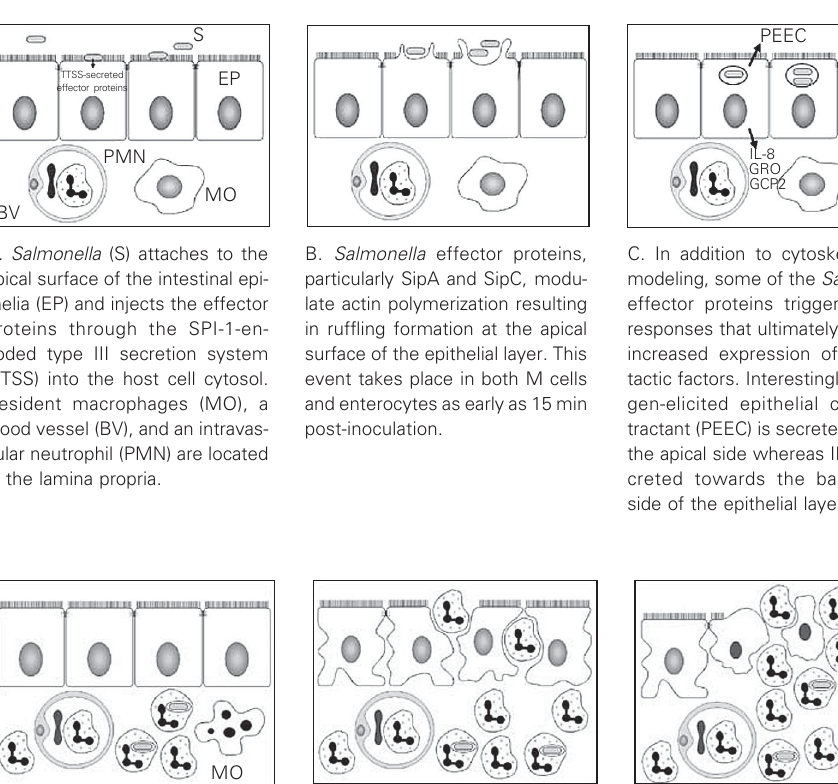
Figure 2. Schematic representation of the pathogenesis of Salmonella -induced enteritis, with the most significant events described from A through